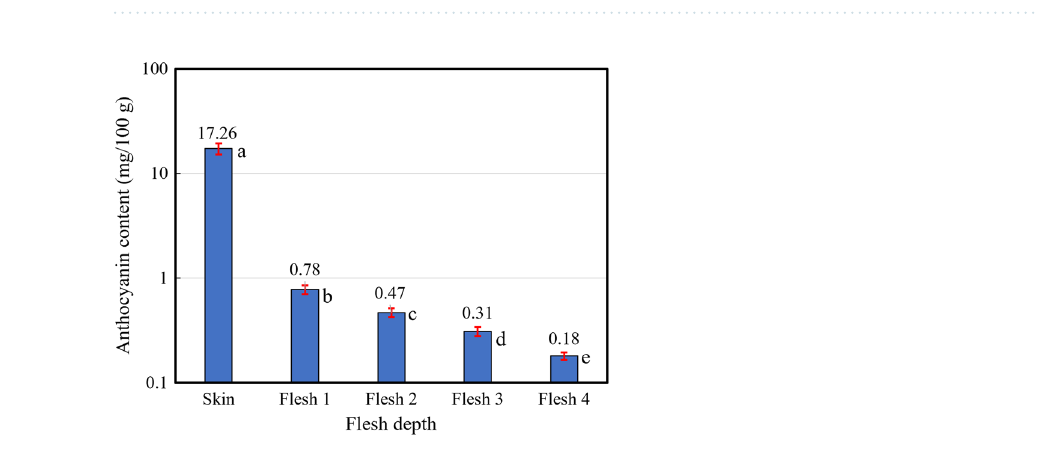
Figure 2. Red coloration in red-fleshed apple ‘Kurenainoyume’. Three samples with low ( a ), medium ( b ) and high ( c ) levels of red coloration in the flesh were selected. The skin appearance, 3 flesh slices for each sample were illustrated. It was found that the skin color does not exactly reflect the color of the flesh.